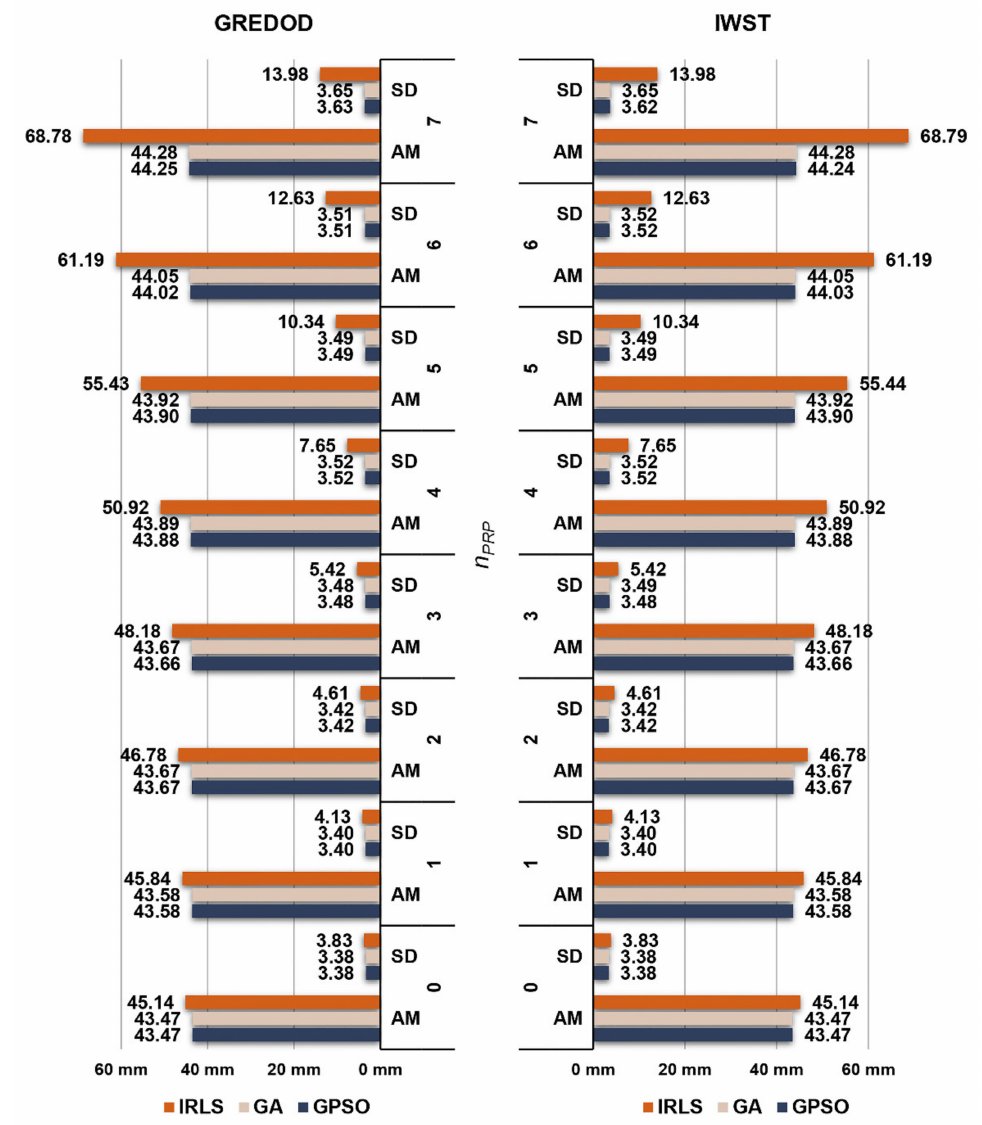
Figure 10. Arithmetic mean (AM) values and standard deviations (SDs) of overall absolute true errors e ˆ of the GREDOD and IWST methods for variant d